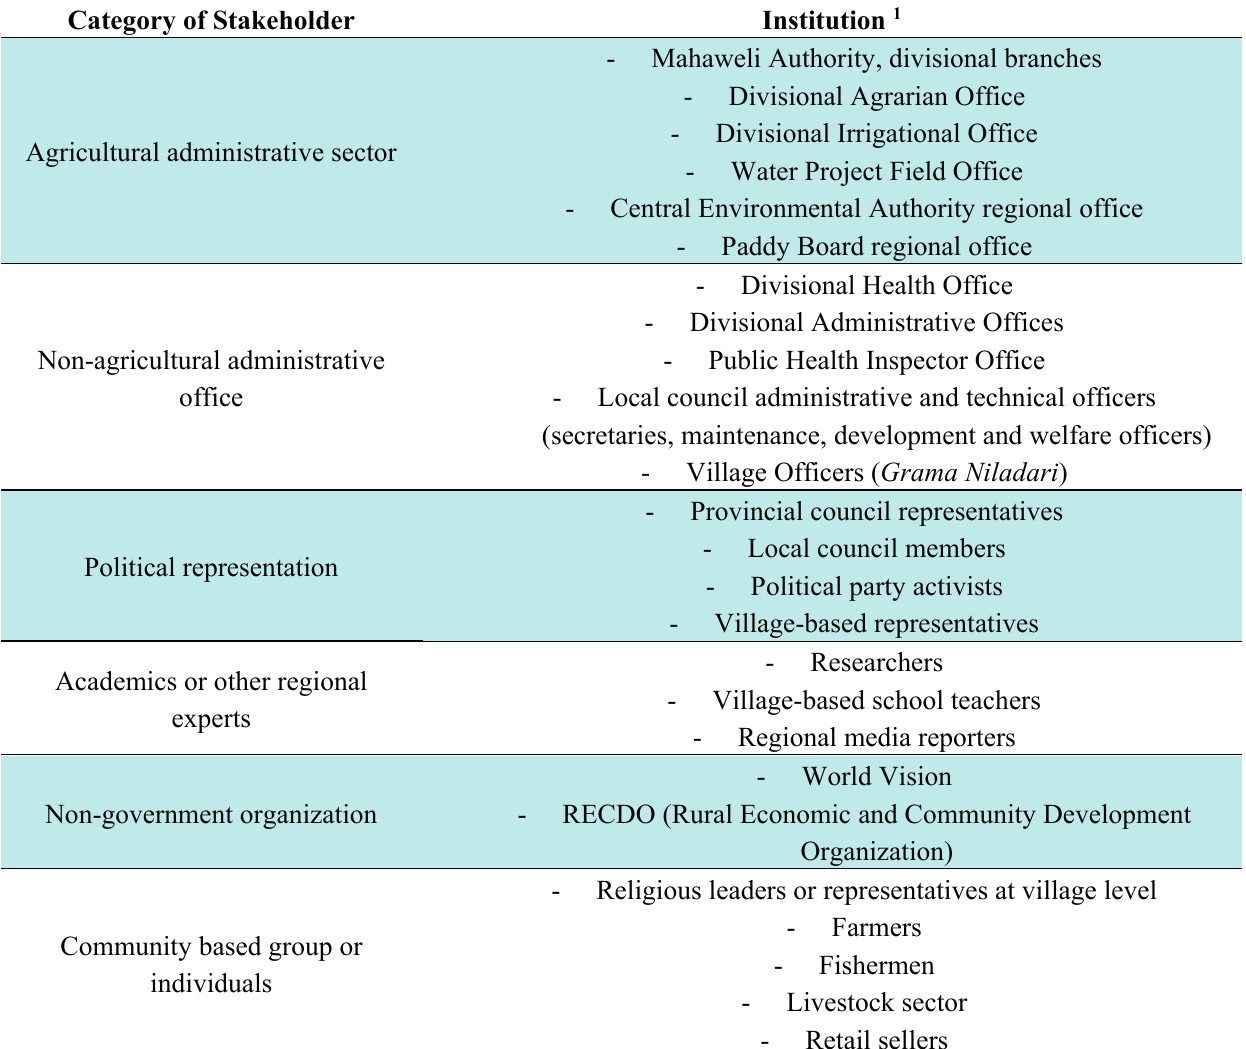
Table 1. The list of institutional interviews